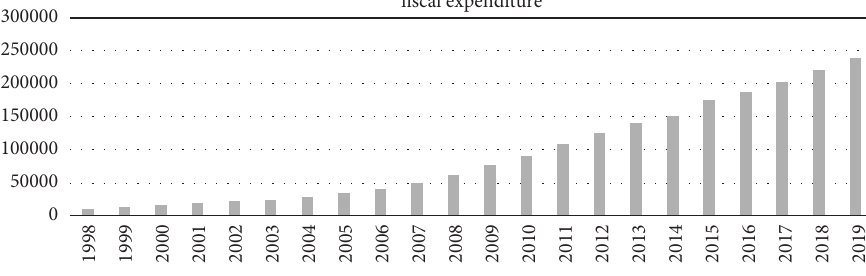
Figure 1: Change trend of China’s fiscal expenditure from 1998 to 2019.